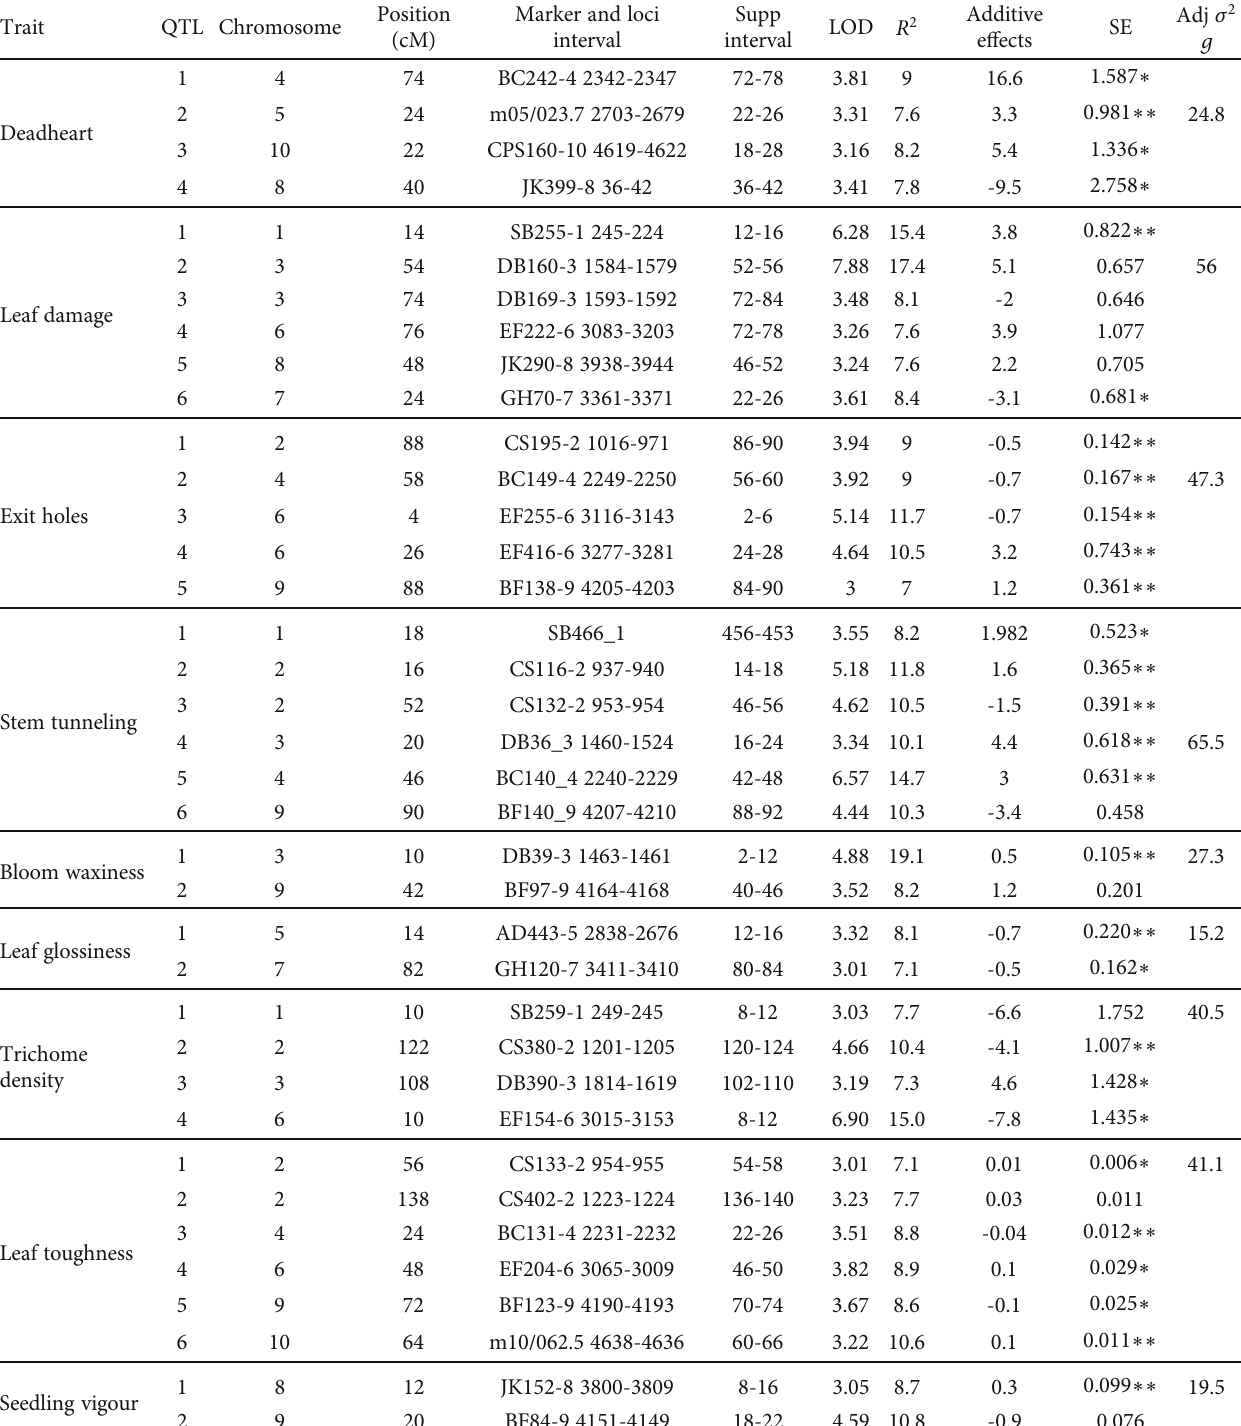
Table 13: Joint analyses for QTLs common for B. fusca and C. partellus damage and morphological traits from the RIL population derived from ICSV 745 × PB15520 ‐ 1